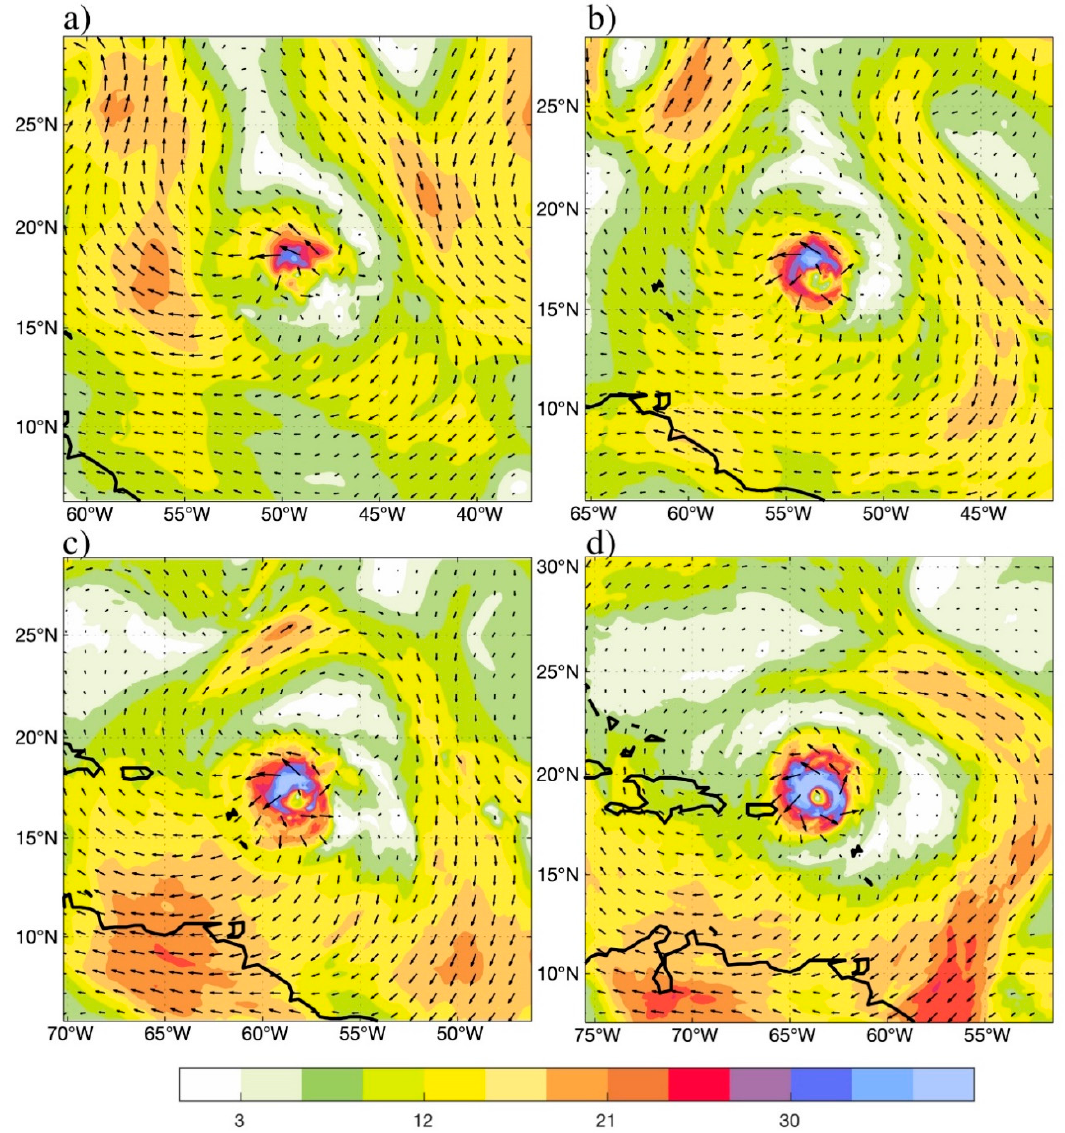
Figure 18. As in Figure 12, except for the Control HWRF without the high-density AMV datasets. ( a ) Initialization for z = 12,860 m wind vectors (m s − 1 , color bar at bottom) at 18 UTC 3 September, and then the HWRF model forecasts at ( b ) tau + 24 h, ( c ) tau + 48 h, and ( d ) tau + 72 h (provided by William E. Lewis, CIMSS).